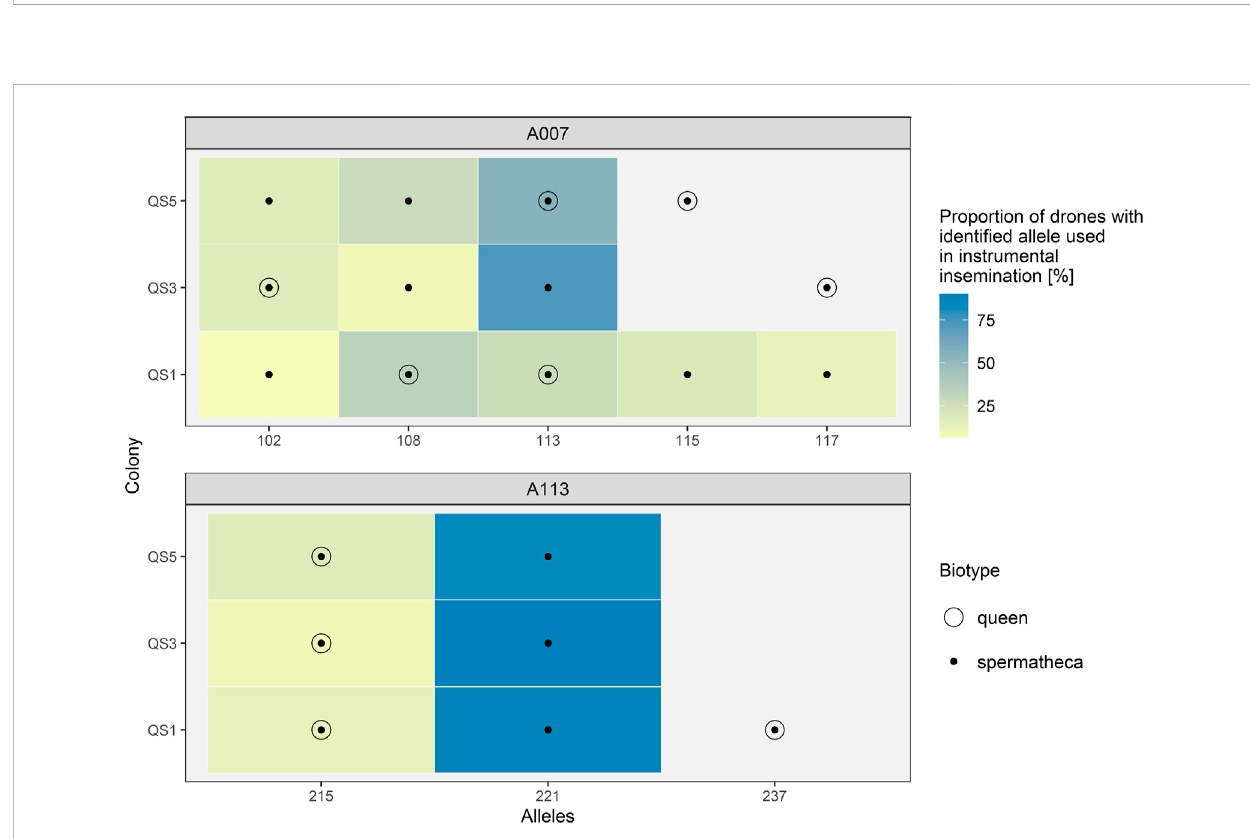
FIGURE 4 Genotypes of A7 and A113 microsatellite loci of spermathecas from instrumentally inseminated queens, their corresponding queens and drones. Legend: The genotypes of drones are presented as coloured rectangles — The colour indicates the proportion of detected allelic variants in drones. Black dots represent the genotypes detected in each spermatheca. Empty circles indicate the genotype of the